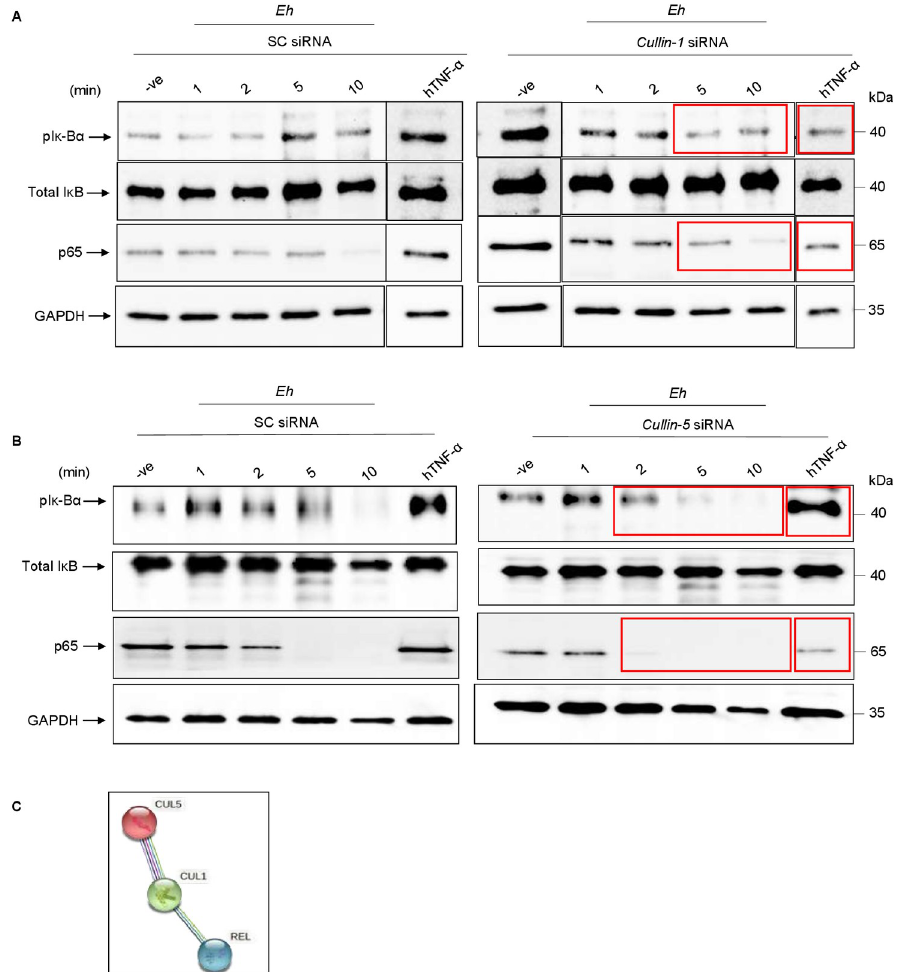
scrambled control (SC siRNA). After 72h, cells were stimulated with Eh for 1-, 2-, 5- and 10-min. Recombinant human TNF- α (hTNF- α ) was used as a positive control for the experiment. Post incubation with Eh , cells were washed